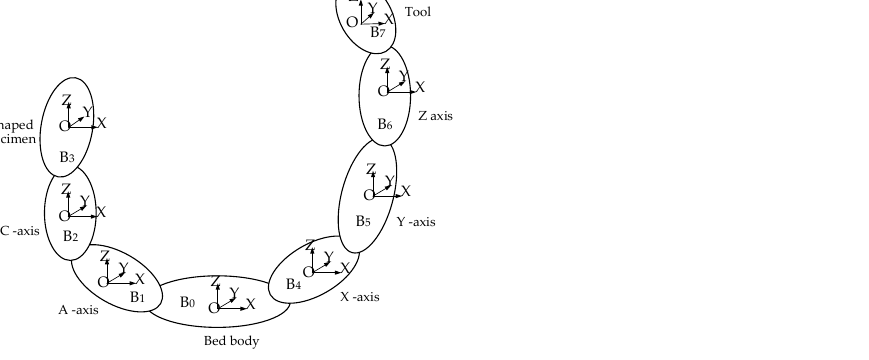
B -Bed body, B -A axis, B -C axis, B -S- Figure 2. Machine topology and coordinate diagram. Figure 2. Machine topology and coordinate diagram. B 0 -Bed body, B 1 -A axis, B 2 -C axis, B 3 -S-shaped 0 1 2 3 B -X axis, B -Y axis, B -Z axis, and B -Tool. shaped specimen, specimen, B 4 -X axis, B 5 -Y axis, B 6 -Z axis, and B 7 4 5 6 7